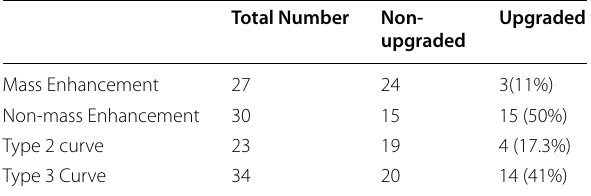
Table 4 MRI imaging criteria of 57 surgically removed high‑risk breast